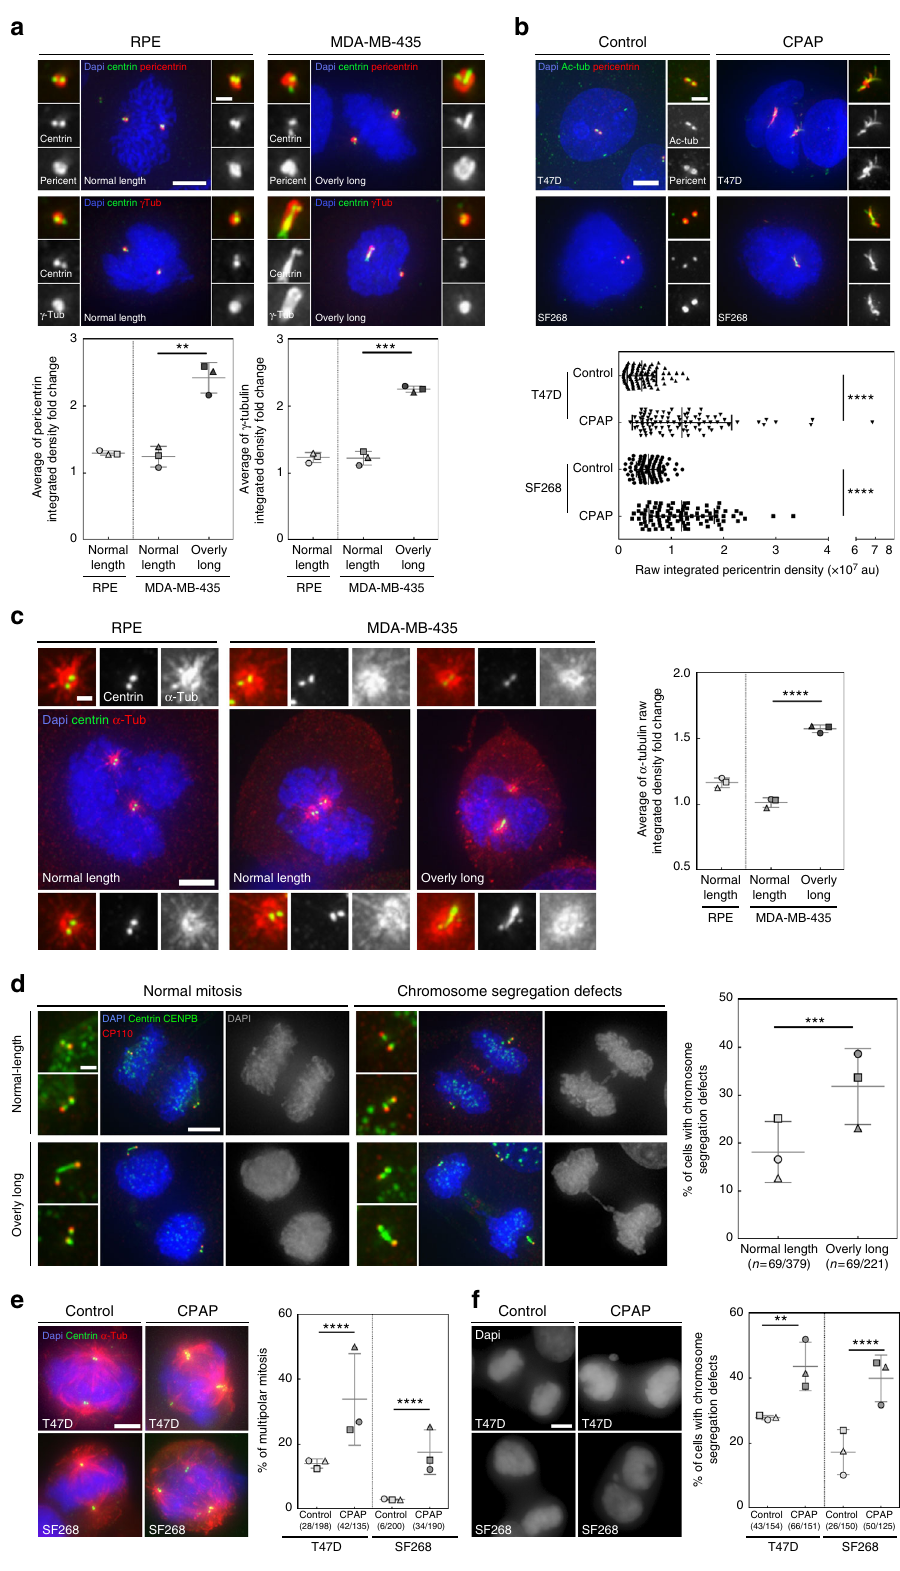
supernumerary centrioles, via both centriole fragmentation and ectopic procentriole nucleation. Our work represents an impor- tant asset to uncover the origins and consequences of centrosome defects in cancer, and in the development of new tools for cancer diagnosis and therapeutics.